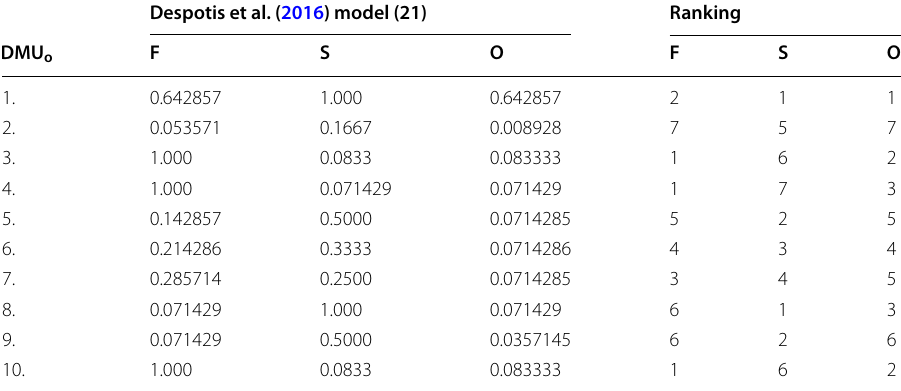
Table 5 Results from Despotis et al. (2016) model (21) Despotis et al. (2016) model (21)